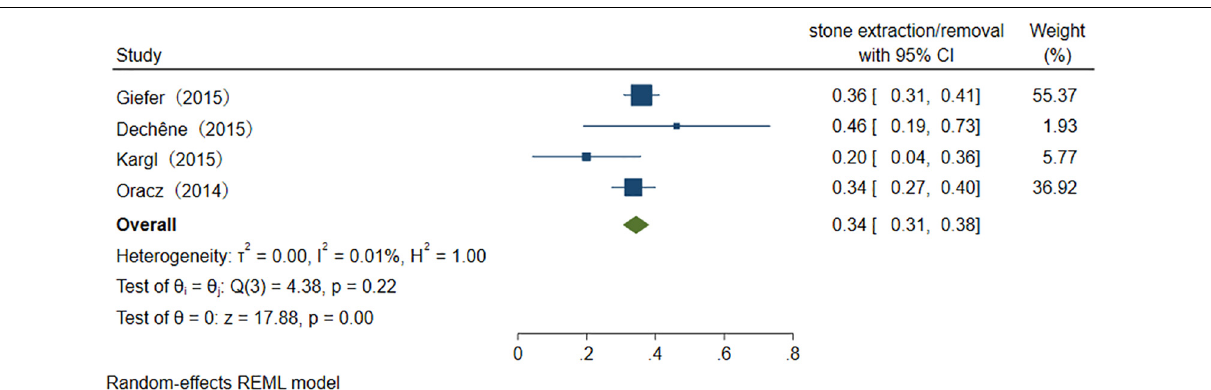
FIGURE 11 | The usage rate of stone extraction/removal.